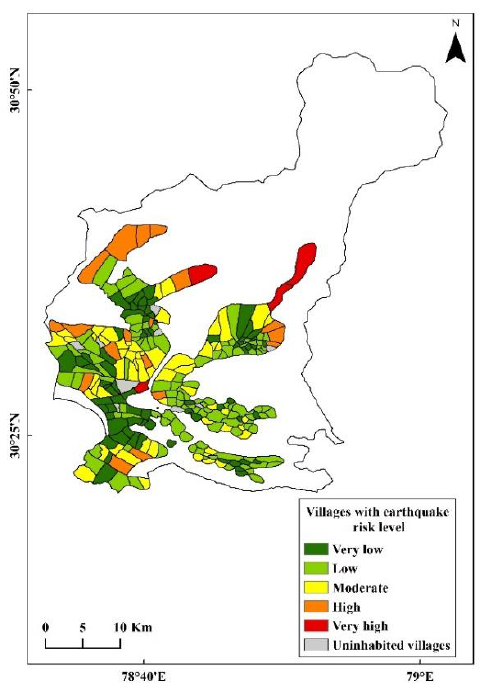
Figure 5. Earthquake risk assessment map for Bhilangana